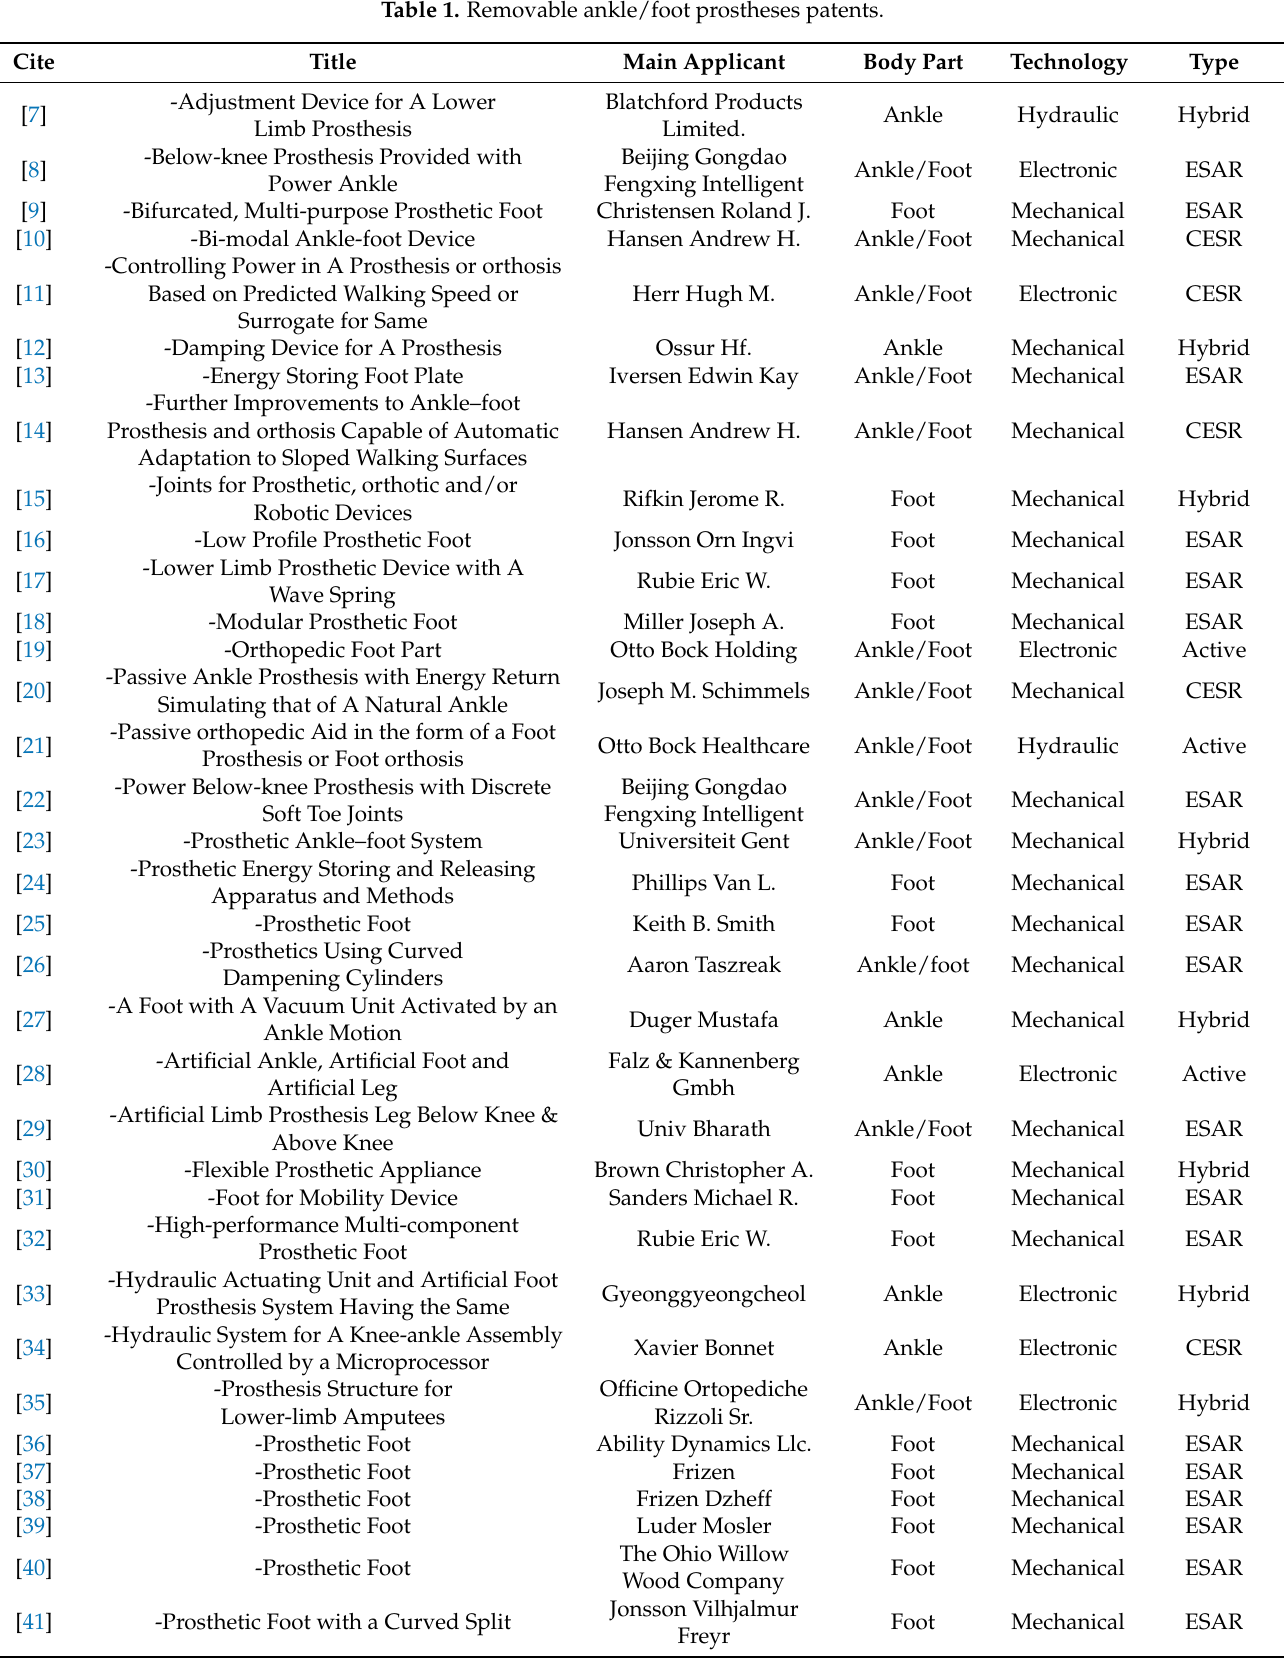
Table 1. Removable ankle/foot prostheses